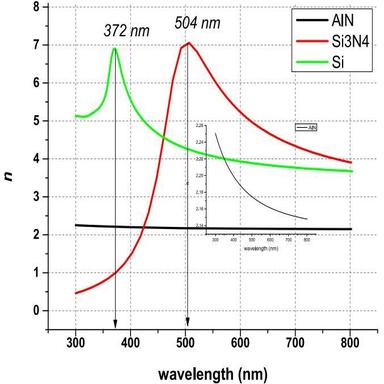
Dielectric constants of AlN, Si3N4 and Si stack.